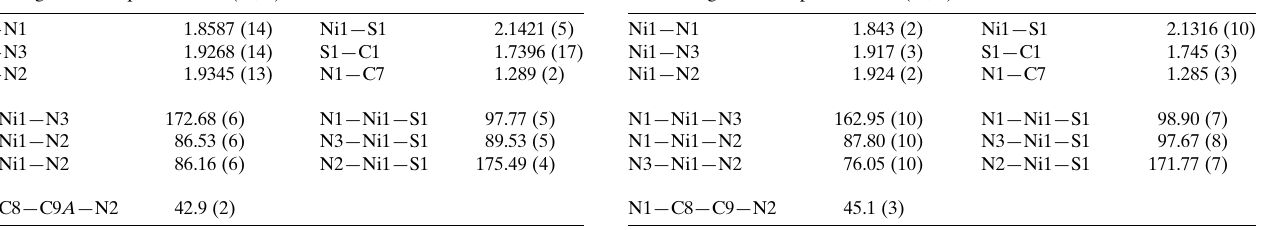
Table 2 Selected geometric parameters (A˚ , (cid:3) ) for 2 .